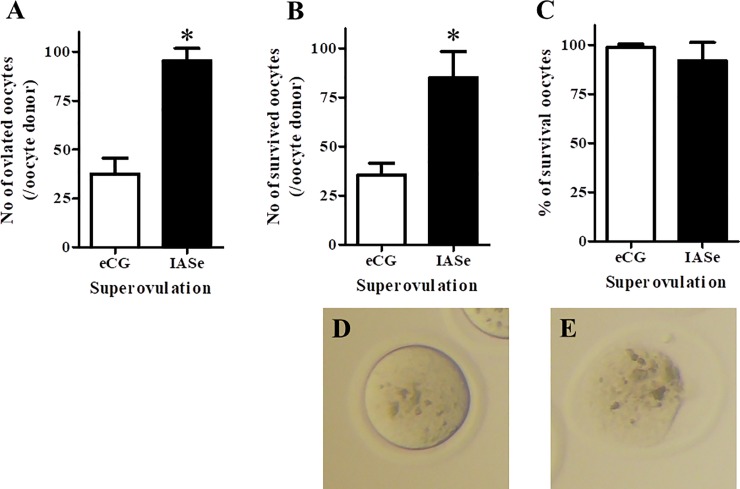
Effect of superovulation induced by eCG or IASe treatment on the viability and yield of vitrified–warmed oocytes.A) The number of ovulated oocytes per oocyte donor was counted after removing the cumulus cells. B) The number of surviving oocytes per oocyte donor was counted after vitrifying and warming. C) The rate of survival of oocytes (%) was calculated as the number of morphologically normal oocytes divided by the sum of morphologically normal and dead oocytes × 100. Morphologically normal oocyte (D) and dead oocyte (E) after vitrifying and warming are shown. The results are expressed as mean ± SD (n = 5). *P < 0.05 compared with eCG.